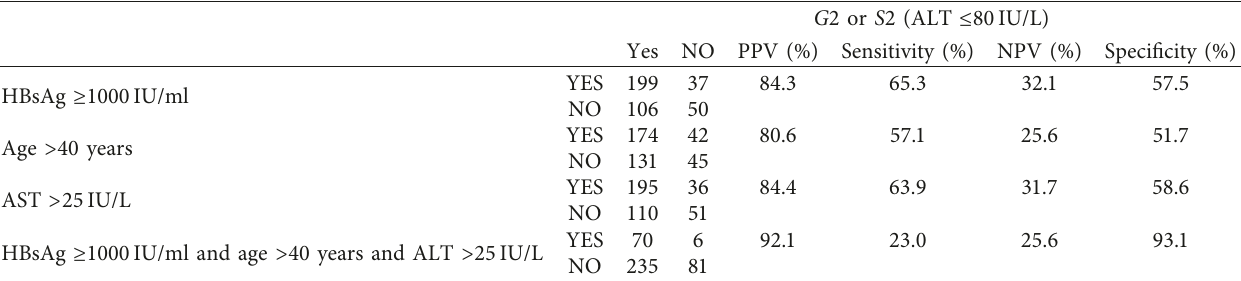
Figure 3: Chances of histological abnormalities among HBeAg-negative chronic HBV infection patients based on HBsAg level , AST level, and age. Table 3: Predictive values for serum levels of HBsAg, AST, and age for identifying significant histological changes in HBeAg-negative patients ( n (cid:31)